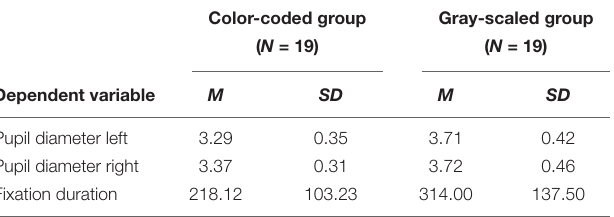
TABLE 3 | Means and standard deviations of eye-tracking variables.